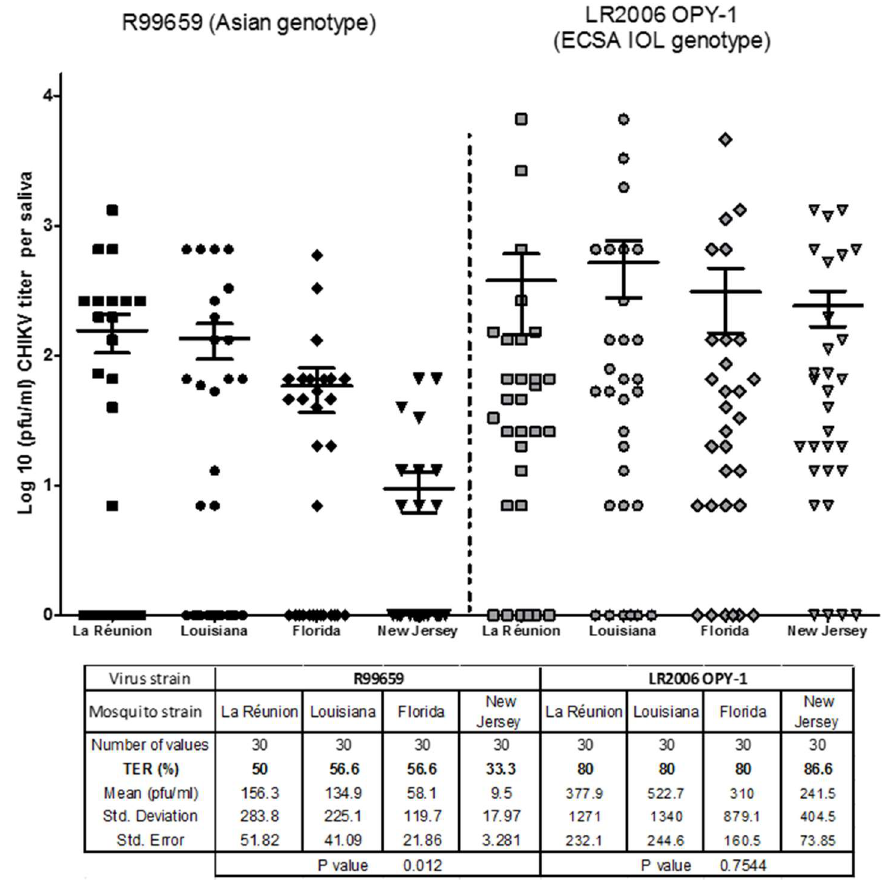
Figure 2. Transmission efficiency rate (TER) assay of CHIKVs in four Ae. albopictus strains. The TER (prevalence) and virus titer were determined for Ae. albopictus (three U.S. strains and the La Réunion strain) orally infected with either CHIKV R99659 (blood meal virus titer 5.6 × 10 7 pfu/mL) or CHIKV LR2006 OPY1 (blood meal virus titer 6.6 × 10 7 pfu/mL). Virus titers were determined 9 days later in saliva by plaque assay. Saliva for each female was collected using forced saliva capillary method. The number of mosquitoes assayed from each mosquito and CHIKV strain and the prevalence (% infection) are listed. Horizontal bars show mean titer values with SEM. p value of virus titers among the Ae. albopictus strains infected with either R99659 or LR2006 OPY1 were p = 0.012 and p = 0.7544,